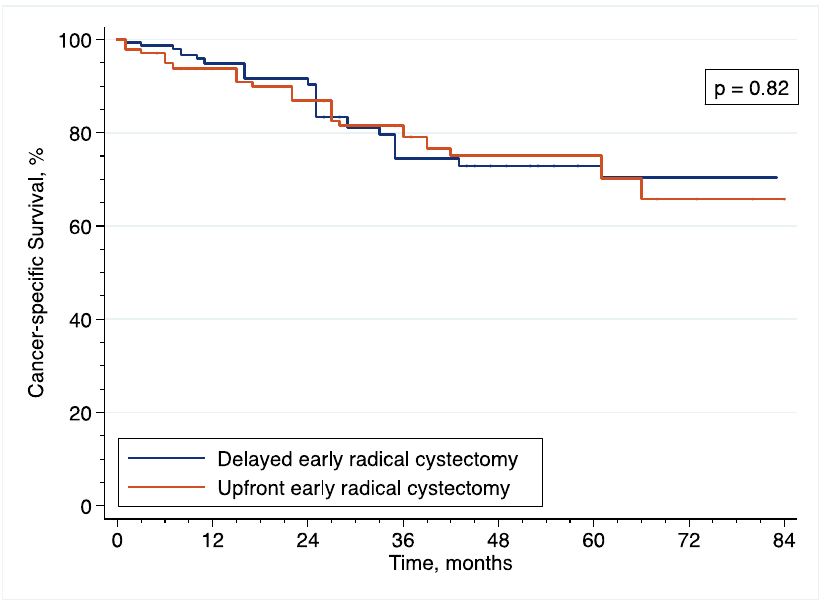
Figure 7. Inverse probability of treatment weighting (IPTW)-adjusted Kaplan–Meier curves that compare the CSS of included patients treated with upfront or delayed eRC for HR-NMIBC.